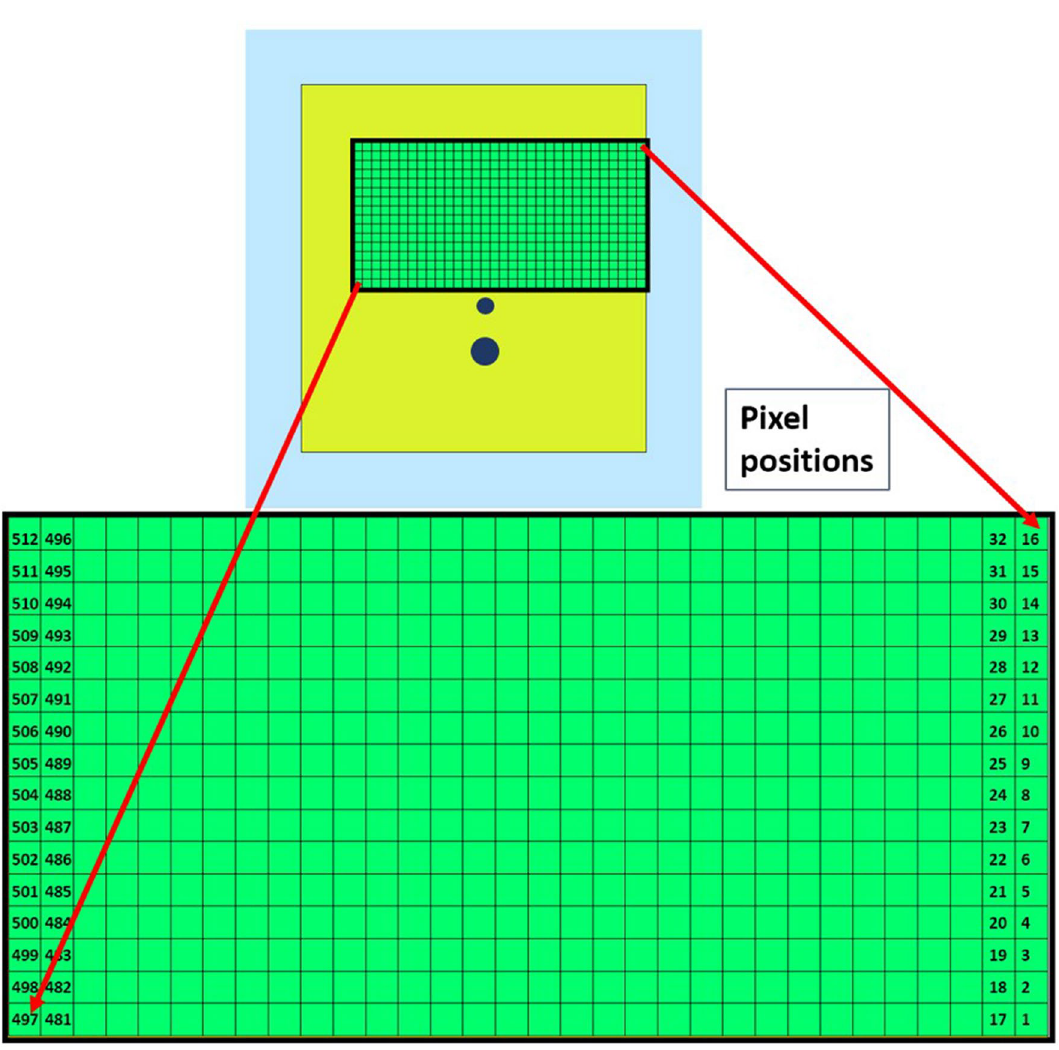
Figure 3. Pixelization of the defected ground area.